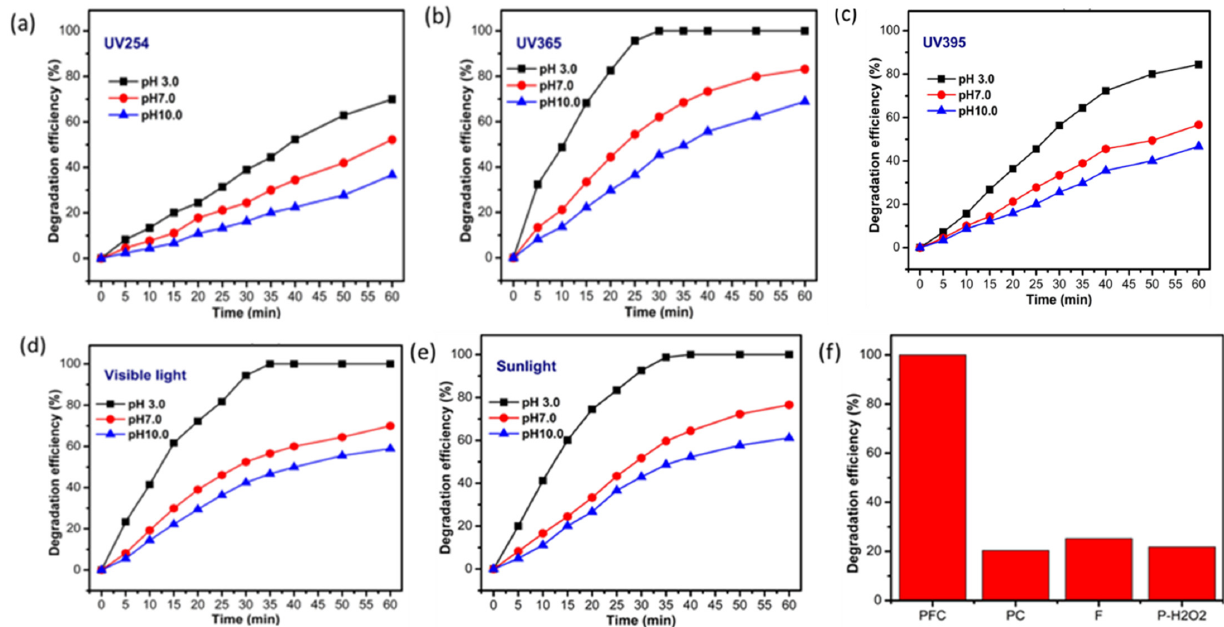
Figure 6. Photodegradation activity of rGO-Y 2 O 3 ( a ) UV 254 nm, ( b ) UV 365 nm, ( c ) UV 395 nm, ( d ) Visible light and ( e ) sunlight ( f ) Comparison of various methods with present studies, PFC: Photo Fenton’s with rGO-Y 2 O 3 catalyst, PC: Photocatalyst (FO), F: Fenton’s process, P-H 2 O 2 : Photo process with hydrogen peroxide at pH 3.